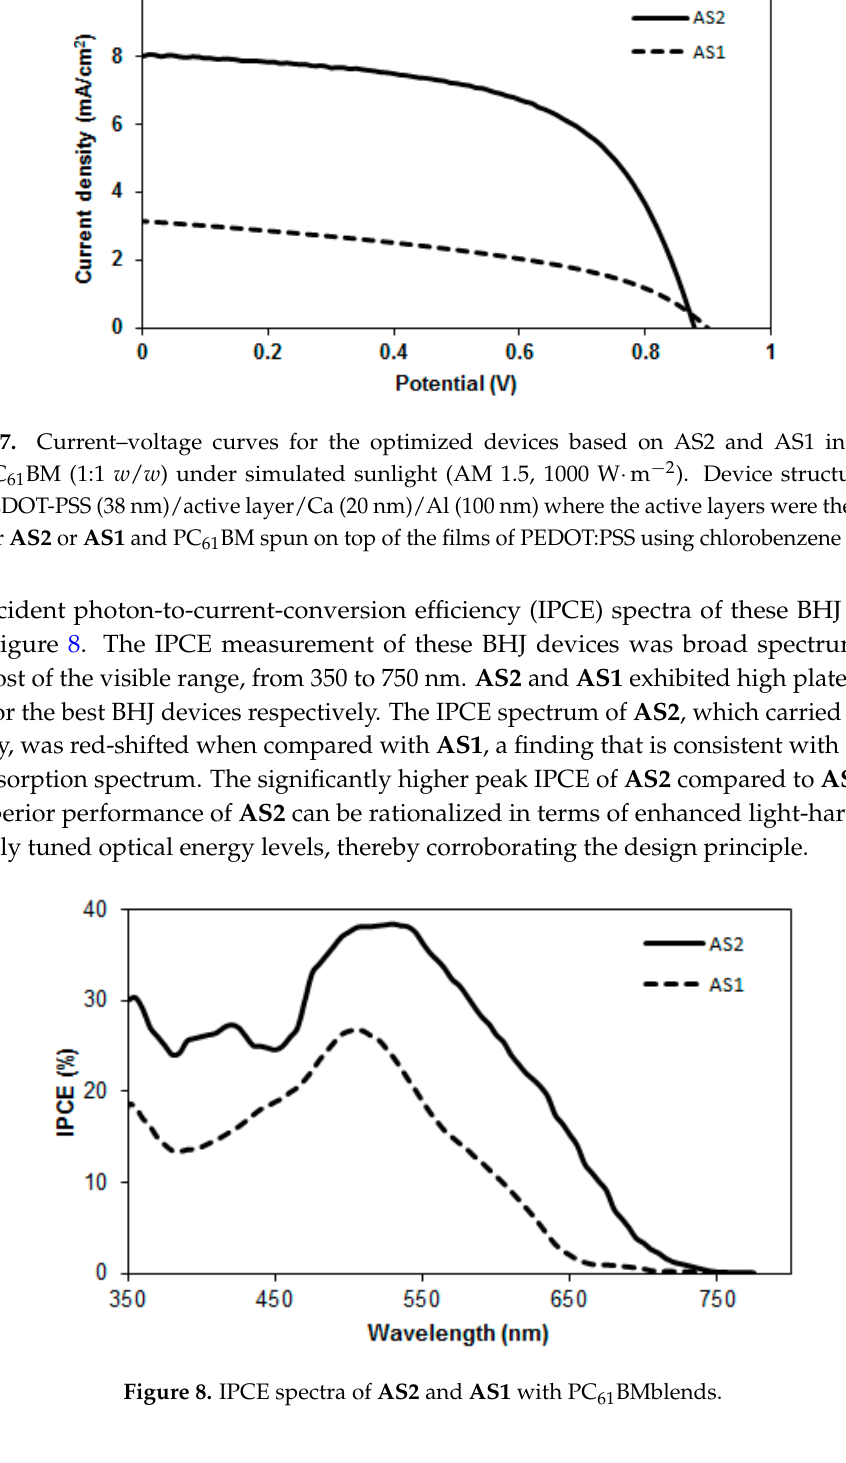
Figure 8. IPCE spectra of AS2 and AS1 with PC 61 BMblends.